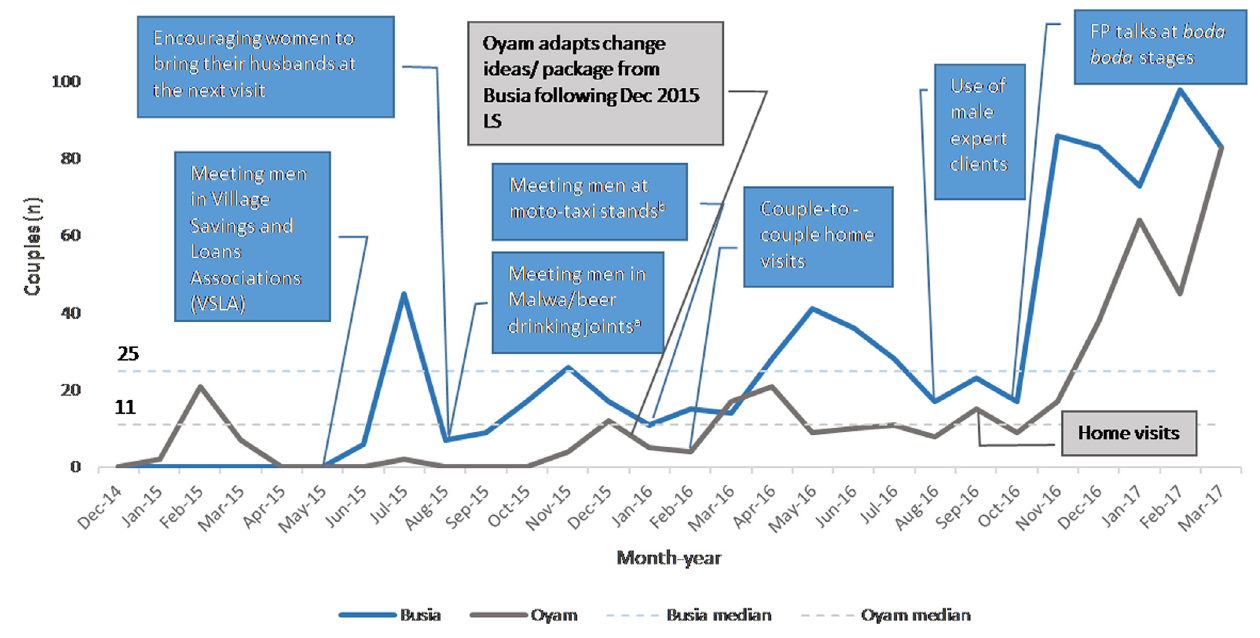
Figure 4. Number of couples counseled, December 2014- March 2017. Annotated run chart with examples of change ideas implemented over time. a Meeting men in Malwa/beer drinking joints: Village Health Team (VHT) members meet with men at popular drinking joints to talk to them about family planning (FP) services using their elevator speeches. b Meeting men at moto-taxi stands: VHTs meet with male motorbike taxi drivers at their waiting stands to talk to them about FP services using their elevator